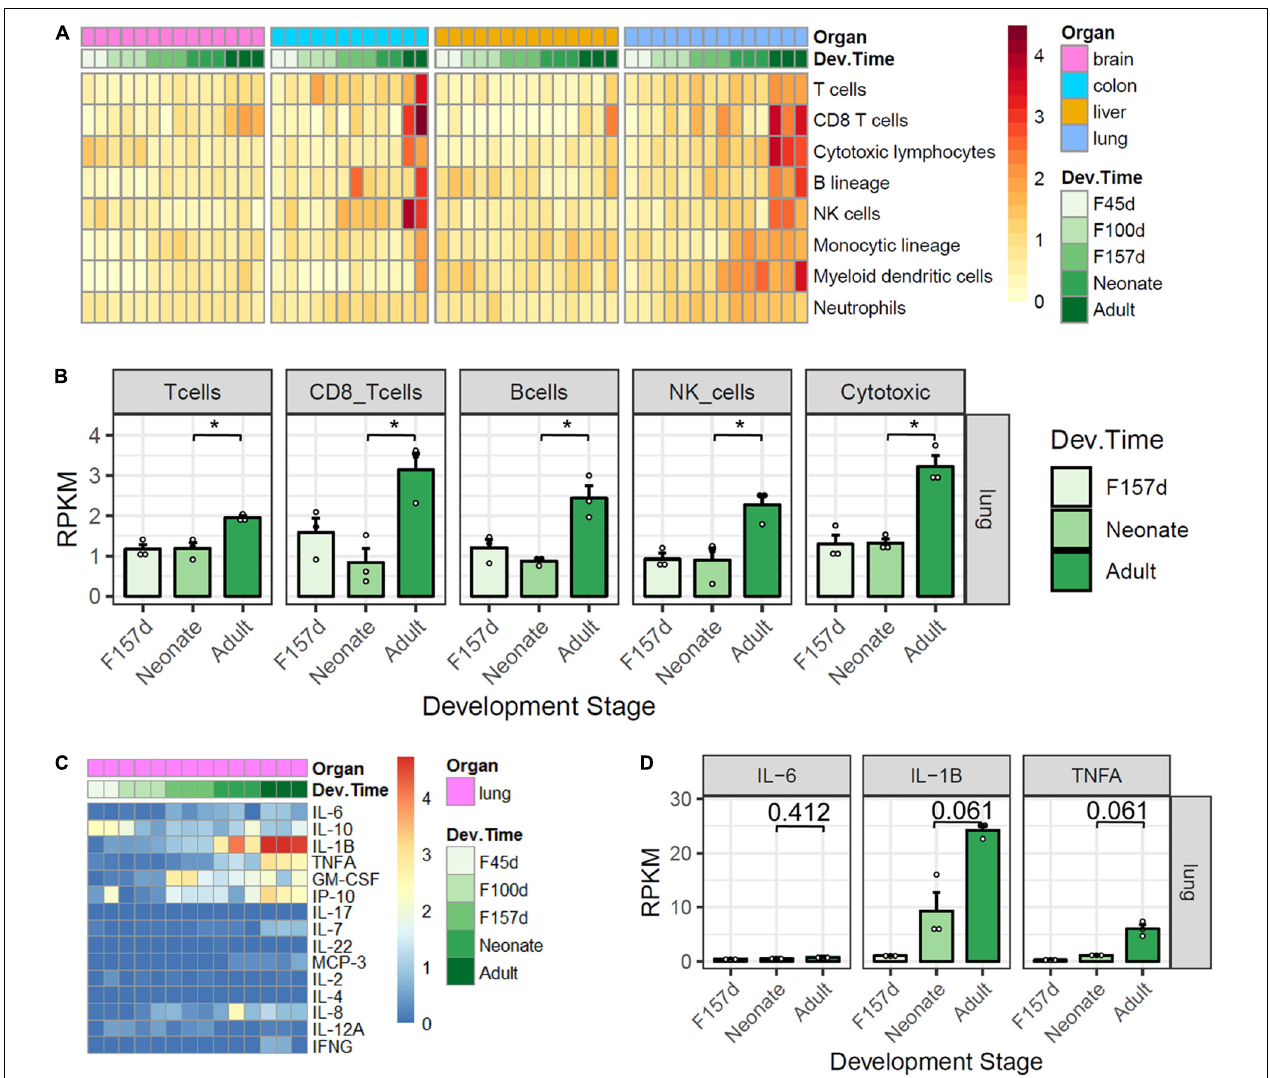
FIGURE 4 | Immune features of four organs in monkey development. (A) Gene expression scores of immune cell populations in developmental tissues. (B) Five immune cells are elevated in adult lungs. (C) Expression profiles of 15 cytokines. (D) IL-1 β and TNF- α are elevated in adult lungs. P -value was calculated by unpaired Student’s t -test and adjusted by using the Benjamini and Hochberg method for multiple tests. Note: *, adjusted p < 0.05.